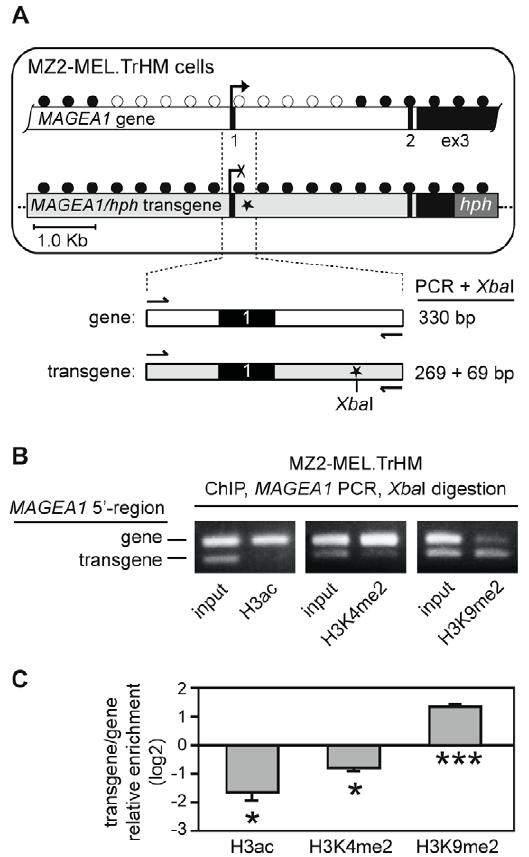
Figure 2. TSA induces transient activation of MAGEA1 in melanoma cells. SK-MEL-23 and EB16-MEL cell lines were exposed to either 300 nM TSA during 24h ( A ), or 1 m M 5-azadC during 96h ( B ), and RNA was extracted from the cells at days 1, 4 and 7 after TSA treatment or at days 4, 7, 10 after 5-azadC treatment. MAGEA1 expression levels were determined by quantitative RT-PCR. Values, which derive from three independent experiments, were normalized by the ACTINB expression level, and are expressed relative to the levels found in non-treated cells (ctrl). * P , 0.05, ** P , 0.01, *** P , 0.001. C , The effect of TSA and 5-azadC on MAGEA1 5 9 -region DNA demethyl- ation was assessed by applying MS-PCR to DNA samples extracted 10 days after the beginning of the treatments. Data (fold demethylation) correspond to the relative amount of unmethylated sequences in treated cells reported to that in untreated cells (ctrl). Values represent the mean ( 6 sem) of three independent qMS-PCR experiments. * P , 0.05, ** P , 0.01. In order to detect rare cells where MAGEA1/hph transgene activation might have occurred, and which may have remained invisible in our RT-PCR and MS-PCR analyses, we submitted the differently treated MZ2-MEL.TrHM cell populations to selection in hygromycin. After 13 days of selection, hygro r colonies were counted. The mean frequency of hygro r clones obtained following either the 24h or the 72h TSA treatment (6 6 10 -6 and 5.5 6 10 -6 , respectively) was not higher than that observed for untreated control cells (9.5 6 10 -6 ), and corresponded therefore to the background level of spontaneously hygro r revertant cells (Fig. 4D). In comparison, treatment with the suboptimal dose of 5- hygro r clones ( . 3 6 10 -4 ). Taken together, these results indicate